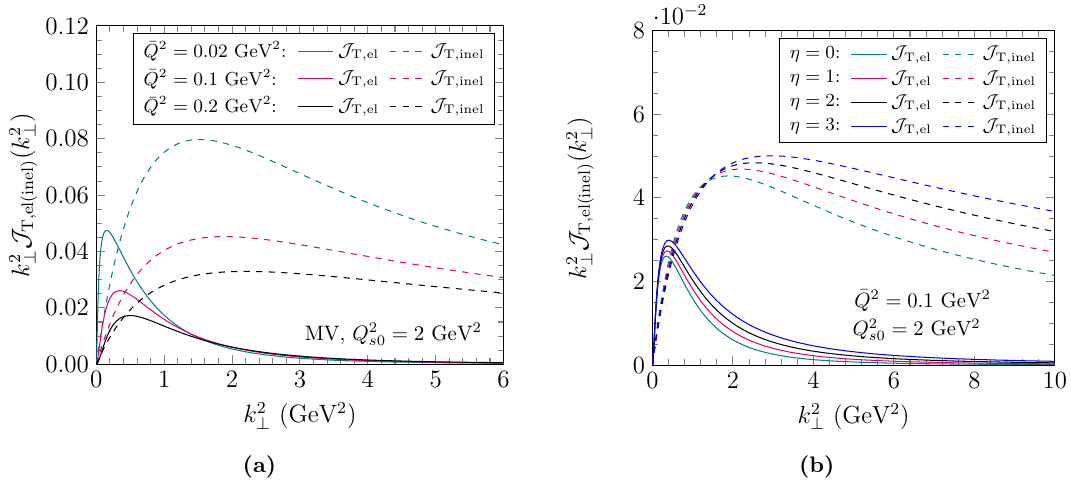
Figure 5. (a) The transverse elastic and inelastic cross-sections multiplied by k 2 functions of k 2 up to k 2 = 3 Q 2 = 6 GeV 2 and for 3 different values of ¯ Q 2 . (b) Rapidity evolution s 0 ⊥ ⊥ up to η = 3 of the results from the left plot corresponding to ¯ Q 2 = 0 . 1 GeV 2 . We note that Q 2 ( η = 3) ’ 3 . 13 GeV 2 s